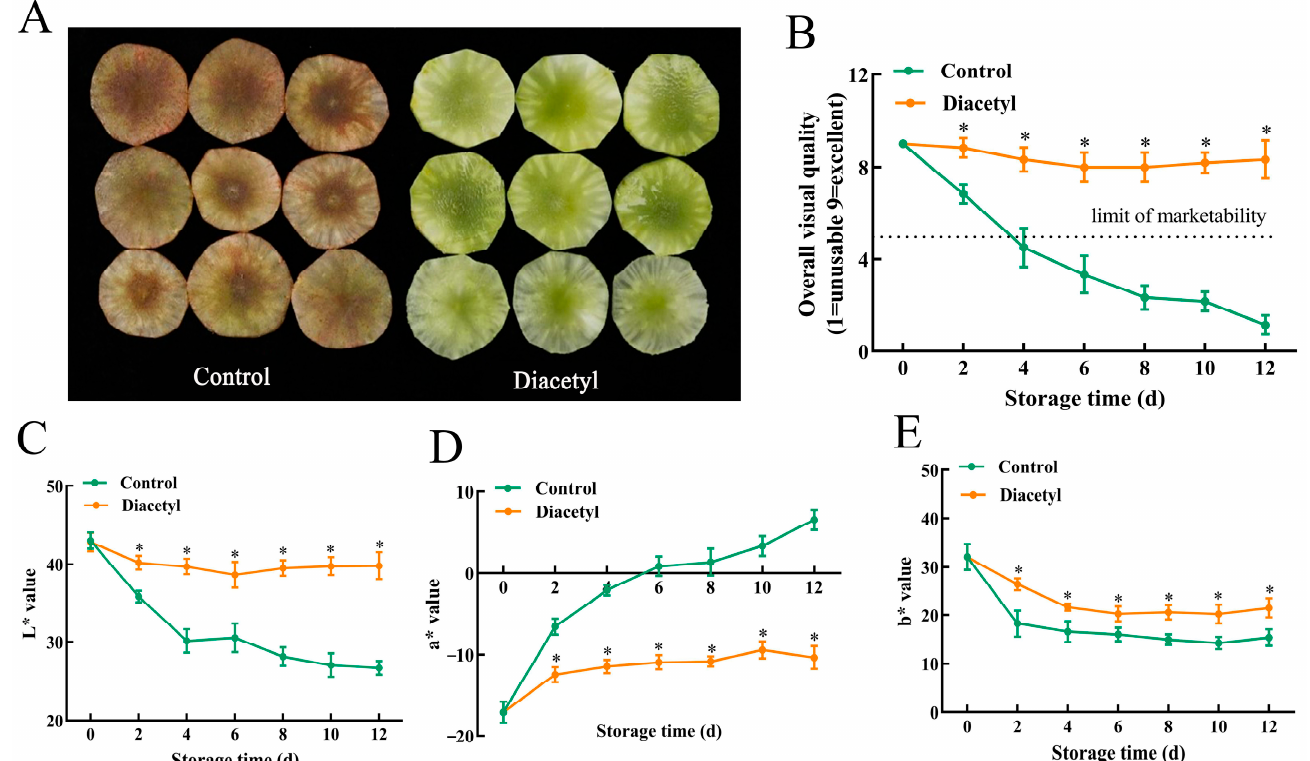
Figure 1. Effect of 10 µ L L − 1 diacetyl treatment on the browning of stem lettuce slices. ( A ) Visual browning photographed on day 12 during storage at 4 °C. ( B – E ) Variations in overall visual quality ( B ), L* ( C ), a* ( D ) and b* ( E ). Asterisks * indicate the significant differences ( p < 0.05) between control and treated groups at the same storage time. Vertical bars represent standard deviations.